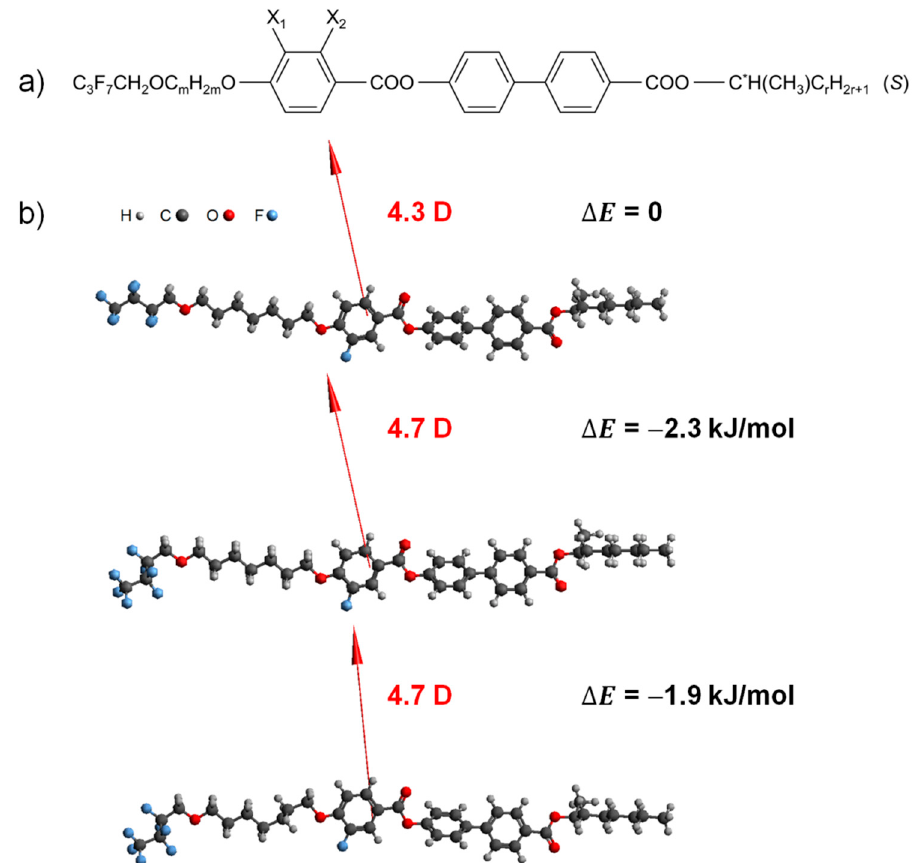
Figure 1. General molecular formula of the 3FmX 1 PhX 2 r family ( a ) and 3F7 F PhH6 molecules opti- mized with DFT method (B3LYP/def2TZVPP) in an extended and two exemplary twisted confor- mations ( b ). The dipole moment vectors are shown, and the relative energy of each conformation is given with respect to the extended conformations in a figure. Table 1. Phase transition temperatures (onset temperature 𝑇 (cid:3042) and peak temperature 𝑇 (cid:3043) ) and en- ergy effects (enthalpy change ∆𝐻 and entropy change ∆𝑆 (cid:3404) ∆𝐻 𝑇 (cid:3043) ⁄ ) determined from the DSC re- sults for 2 K/min rate.